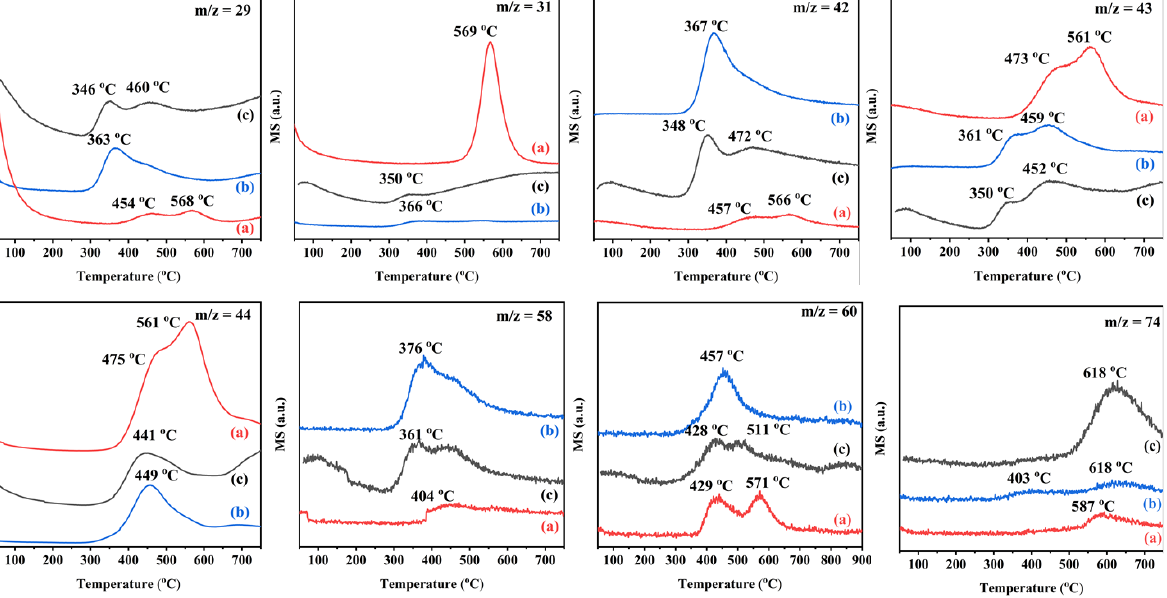
2.09 /TiO 2 , ( b ) 0.33Pd/TiO 2 , and ( c ) 0.36Au/TiO 2